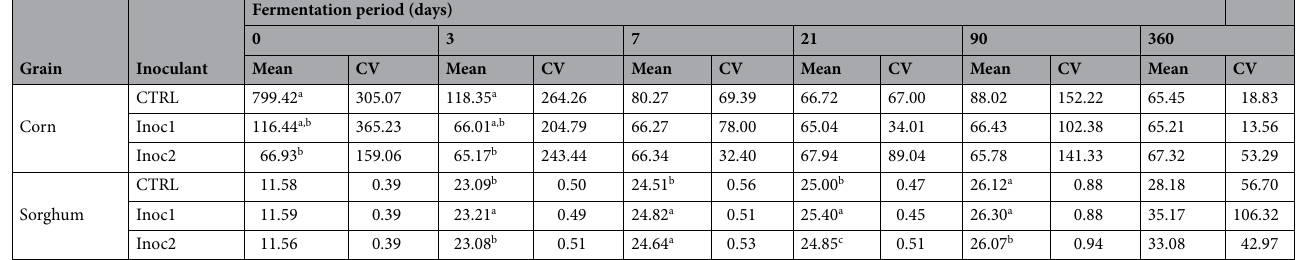
Table 4. Study of inoculants within each fermentation period for the fungal abundance of ground and rehydrated corn and sorghum grain silages after 0, 3, 7, 21, 90 and 360 days of fermentation. CTRL non- inoculated, Inoc1 Lactobacillus plantarum and Propionibacterium acidipropionici , Inoc2 Lactobacillus buchneri. a−b Means followed by different letters in the column differ for each combination between inoculant and grain within each fermentation period by credibility interval.